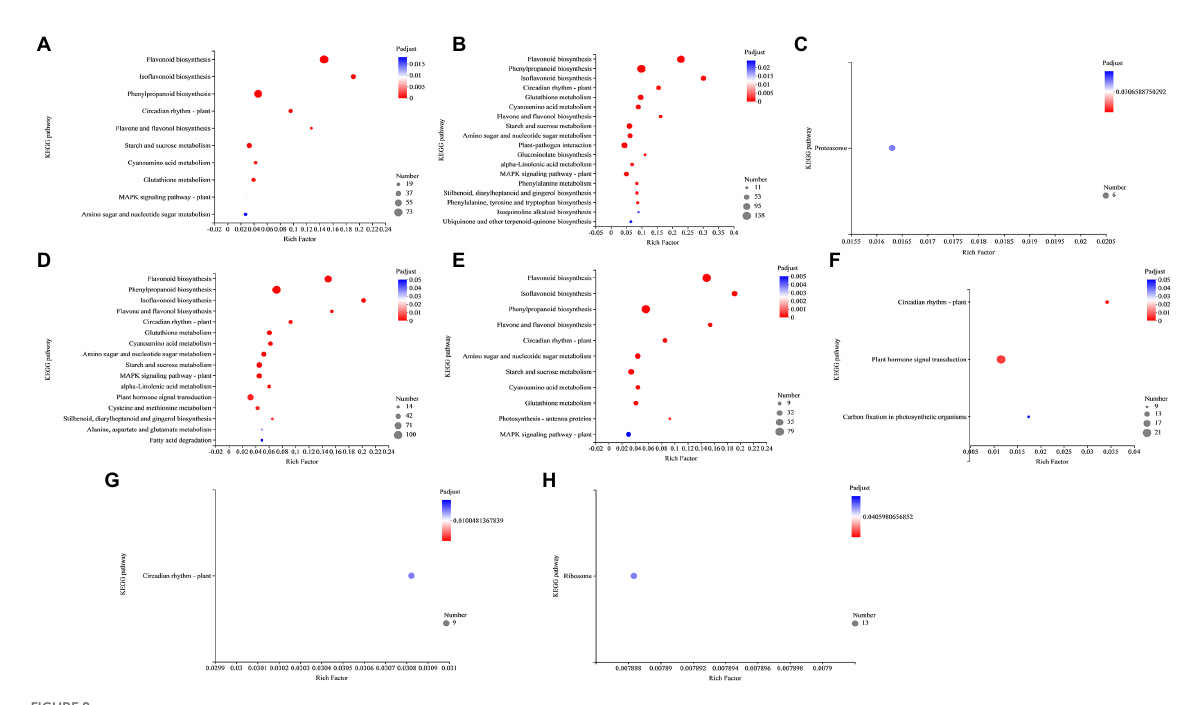
FIGURE 8 KEGG pathway enrichment analysis in the comparisons (A) NMA − P − vs. NMA − P+, (B) NMA − P − vs. NMA+P+, (C) AMA − P − vs. AMA+P − , (D) AMA − P − vs. AMA − P+, (E) AMA − P − vs. AMA+P+, (F) NMA − P − vs. AMA+P − , (G) NMA − P+ vs. AMA − P+, and (H) NMA+P+ vs. AMA+P+. The top 20 KEGG pathways are displayed based on differentially expressed genes ( p adjust < 0.05). The x -axis displays the rich factor, which is the ratio of enriched genes to annotated genes; the larger the rich factor, the more strongly significant the enrichment. The y -axis shows the KEGG pathway. The point size represents the number of genes and the point color indicates the P adjust value. KEGG, Kyoto Encyclopedia of Genes and